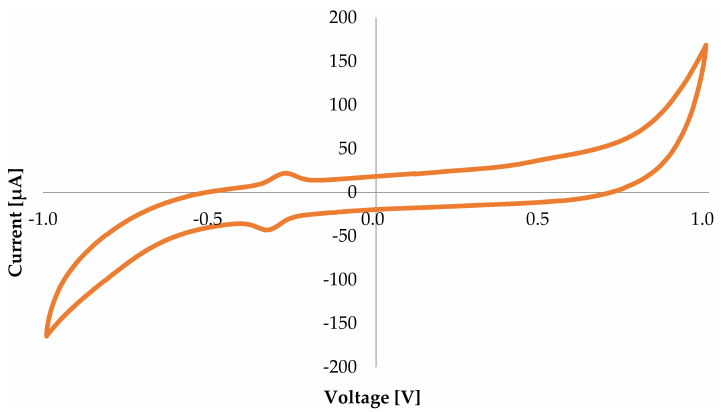
Figure 2. Cyclic voltammetry of the GOx bioanode in a solution containing 15% w / v of glucose (pH 5) at 20 mV s − 1 scan